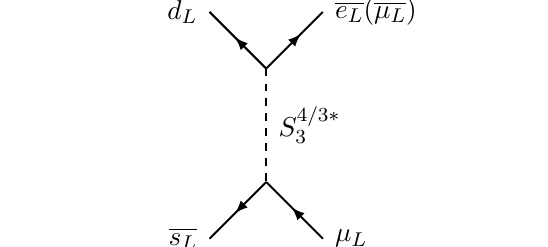
Figure 9 . Dominant contributions to K 0